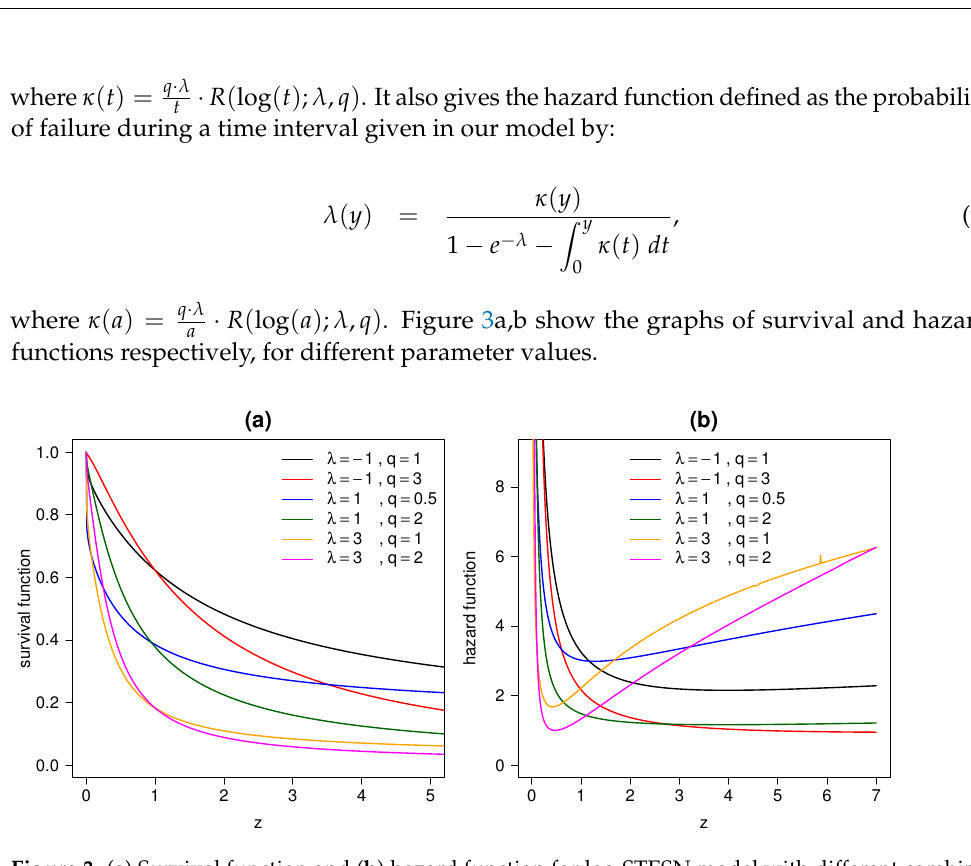
Figure 3. ( a ) Survival function and ( b ) hazard function for log-STESN model with different combina- tions of values for λ and q